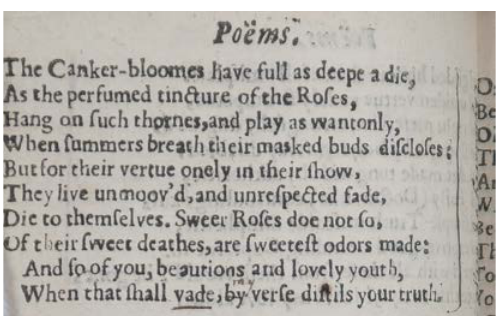
Fig. 6 – Folger STC 22344 Copy 2, sig.